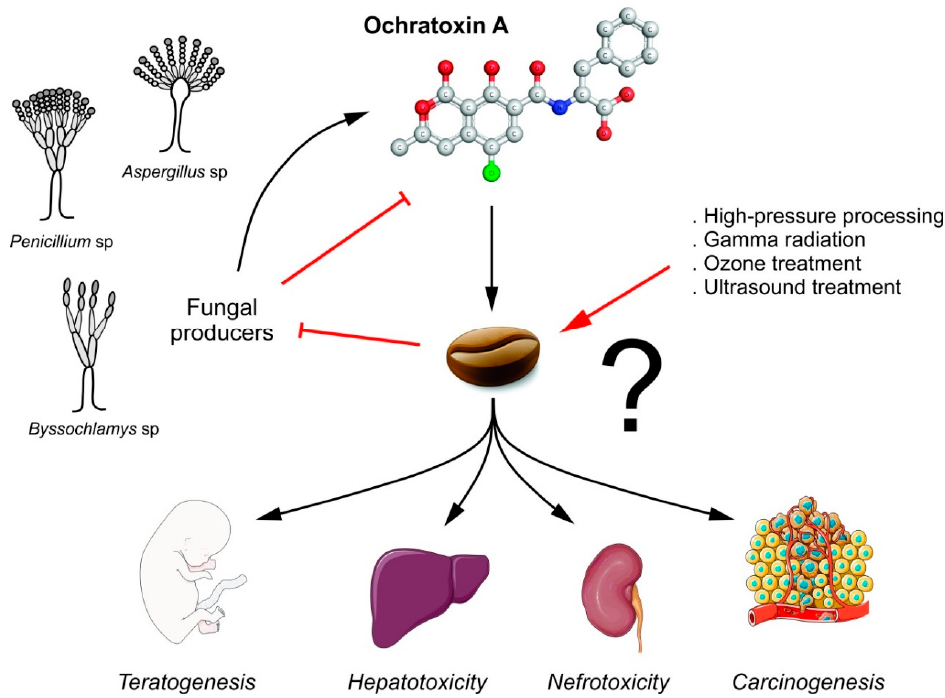
Figure 2. Ochratoxin A in coffee, including its natural sources derived from fungal contamination of beans, their possible toxic effects in humans (black lines) and the potential treatments for minimizing its effects by reducing the fungal contamination of coffee beans (red lines).